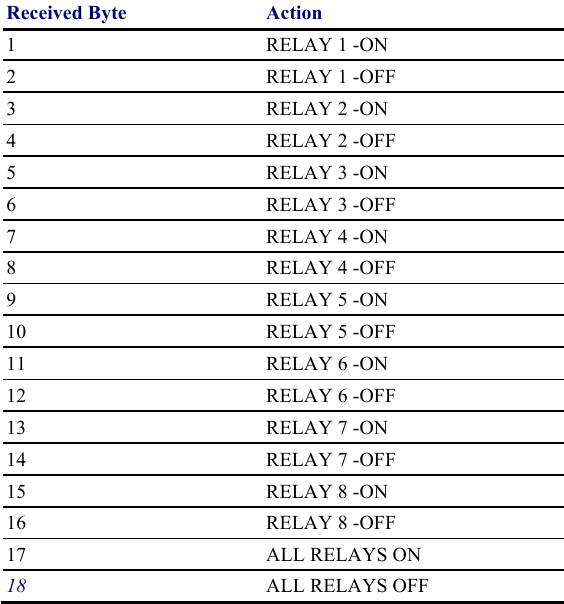
Table 2. Received bytes and all